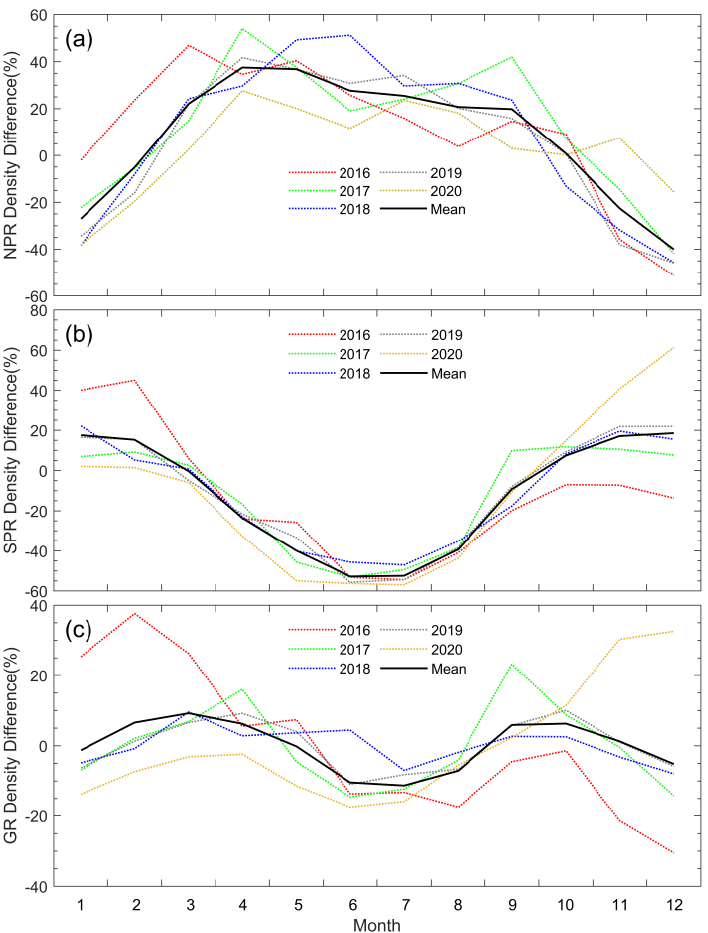
Figure 8. Seasonal variation in thermosphere density difference of ( a ) NPR, ( b ) SPR and ( c ) global region (GR) monthly averages relative to one year from 2016 to 2020.